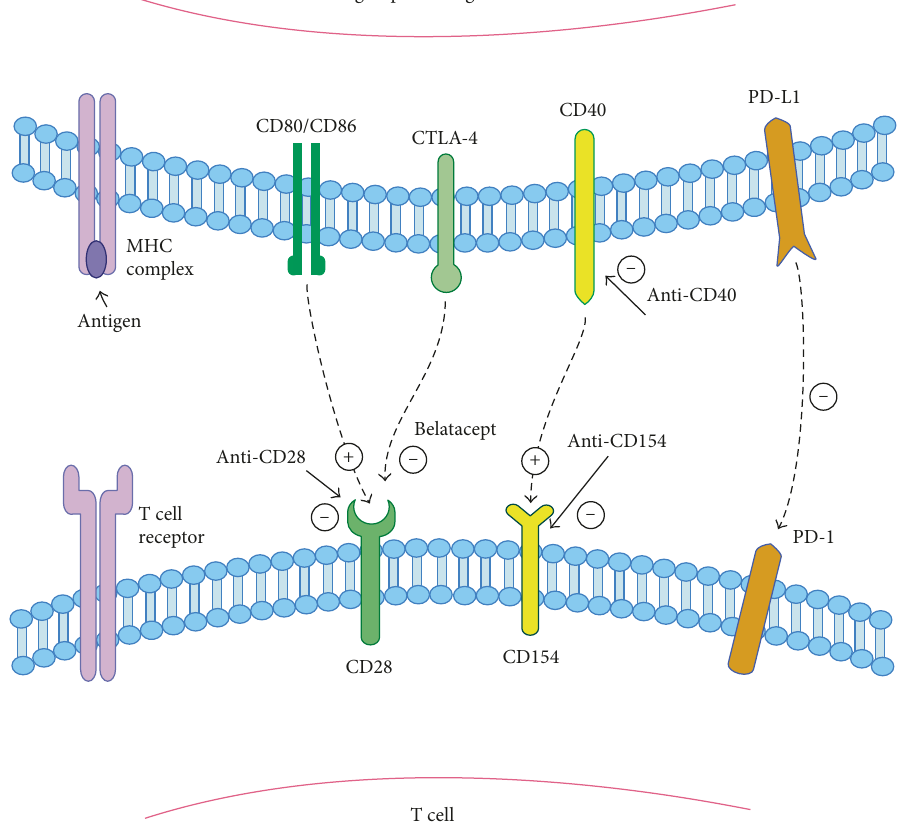
Figure 1: Costimulation pathways in T cell regulation. Upon MHC-antigen interaction with the TCR, costimulation pathways can augment or suppress the activation of the T cell. From left to right, CD28 is activated by CD80/CD86; however, after T cell activation, CTLA-4 is upregulated and with higher a ffi nity than CD80/CD86 and binds to CD28 inhibiting the signal. CTLA-4Ig and belatacept work by taking advantage of their higher a ffi nity to CD28 over CD80/CD86 and thereby block CD80/CD86 activation of CD28. CD154 and CD40 are other potent activators of T cells; monoclonal antibodies against either of these surface proteins have potential for application in transplant immunosuppression. PD-1 is expressed on T cells, and interaction with PD-1 Ligand (PD-L1) produces a suppressive signal to the T